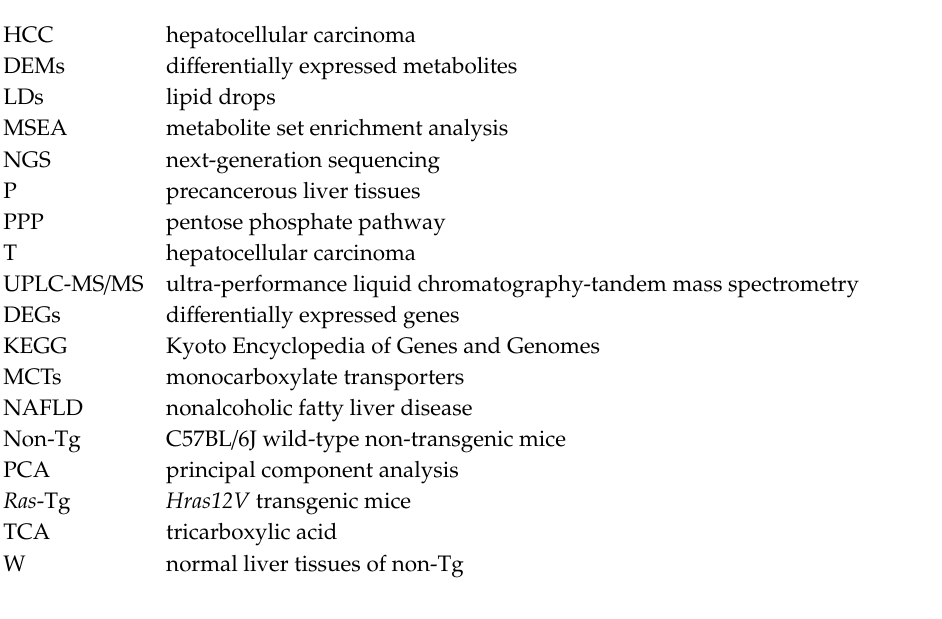
Figure S1: Anatomic and histopathological analysis of hepatic alterations, Figure S2. Experimental design, Figure S3. Typical GCMS total ion current (TIC) chromatograms, Figure S4. Score plots of PCA, PLS-DA, and OPLS-DA based on the metabolite profile data, Figure S5: A. Pathways enrichment analysis for significantly changed metabolites between W and P; B. Pathways enrichment analysis for significantly changed metabolites between P and T; C. Pathways enrichment analysis for significantly changed metabolites between W and T, Figure S6: KEGG pathway enrichment analysis for significantly changed genes, Figure S7: Validation of DEGs in HCC, precancerous, and normal liver tissues by Western blot, Figure S8: The tissue ROS levels detected by fluorescent assay, Figure S9: Tissue stained with Oil Red O, Table S1: Classification parameters of PCA, PLS-DA, OPLS-DA analysis, Table S2: Fold changes and relative p -values of the discriminatory metabolites’ characterization, Table S3: Metabolite set enrichment analysis (MSEA) for hepatocarcinogenesis, Table S4: DEGs between HCC, precancerous, and normal liver tissues, Table S5: KEGG pathway enrichment analysis for up-regulated and down-regulated genes, Table S6: Primer base sequences for RT-qPCR, Table S7: Parameters for LC-MS-MS analysis, Table S8: Detailed information for the primary and secondary antibodies, Supplementary Information: Materials and